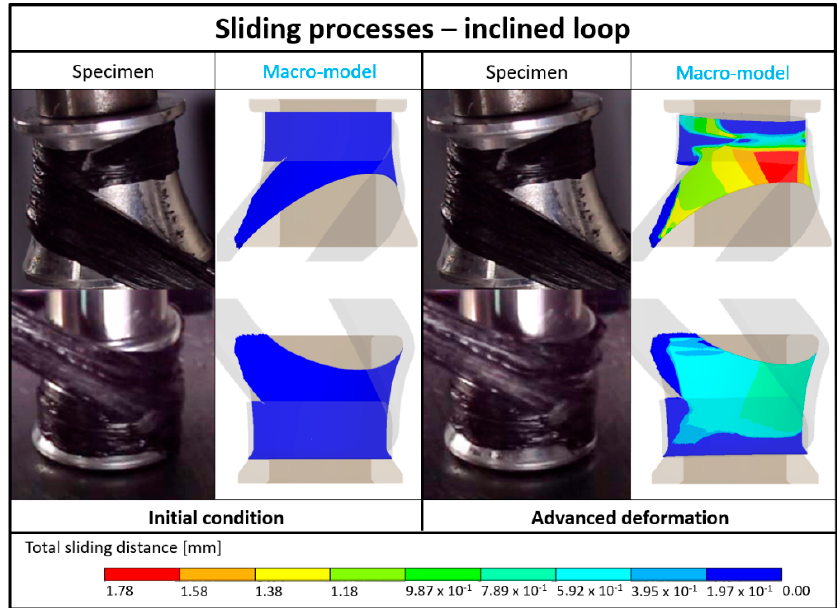
Figure 24. Sliding processes at the inserts of the inclined loop (specimens and model).